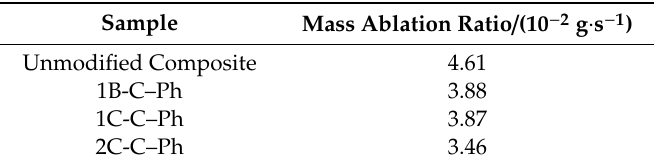
Table 4. Mass ablation ratio of the modified C–Ph composites.